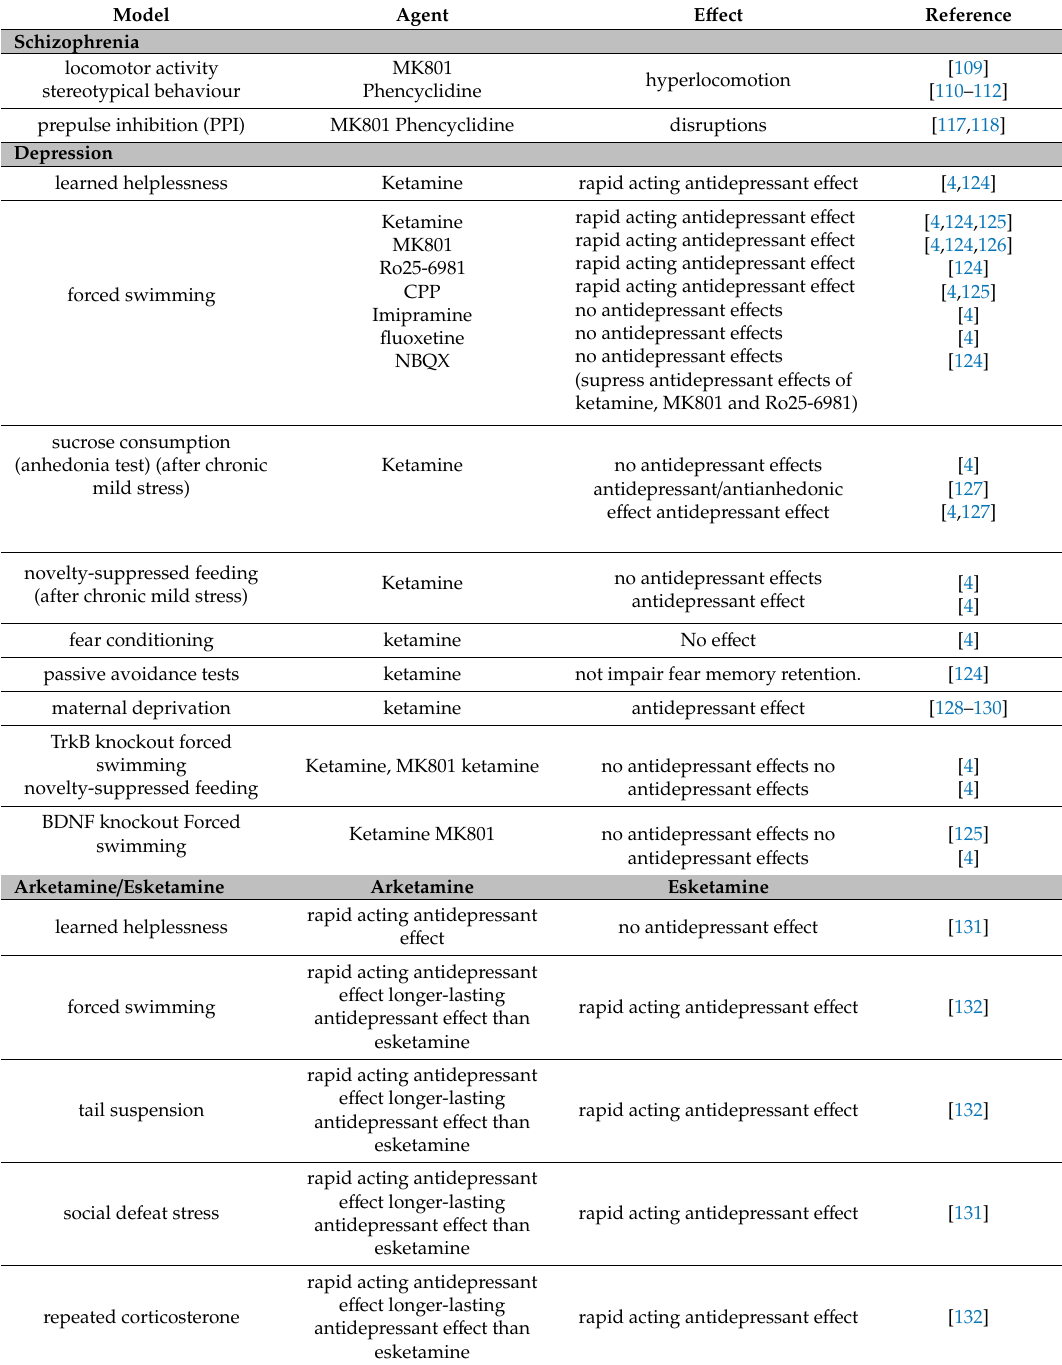
Table 2. Behavioural study assessing ketamine and other